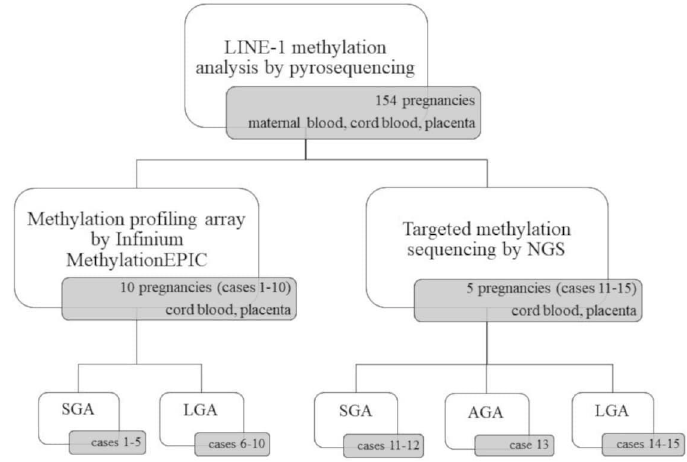
Figure 1. Schematic overview of the experimental design. SGA, small for gestational age; AGA, appropriate for gestational age; LGA, large for gestational age.